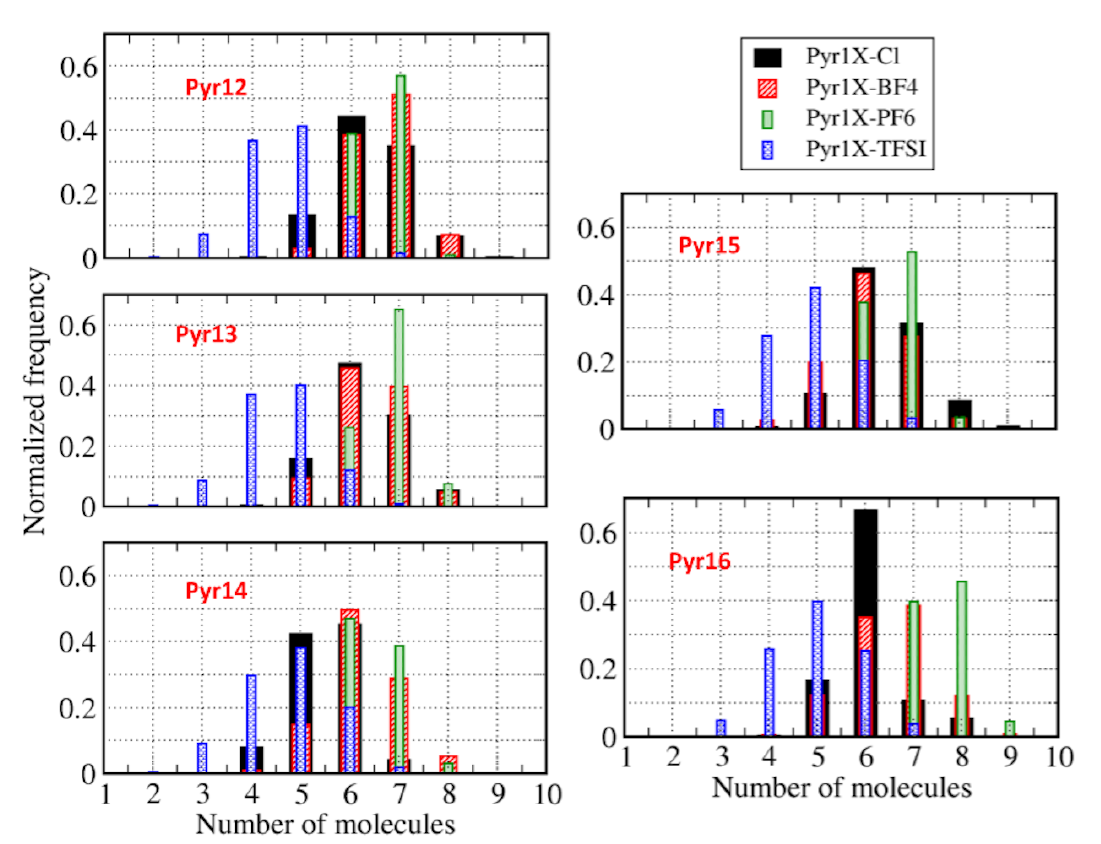
Figure 5. Histograms of the number of anions within 5 Å of one